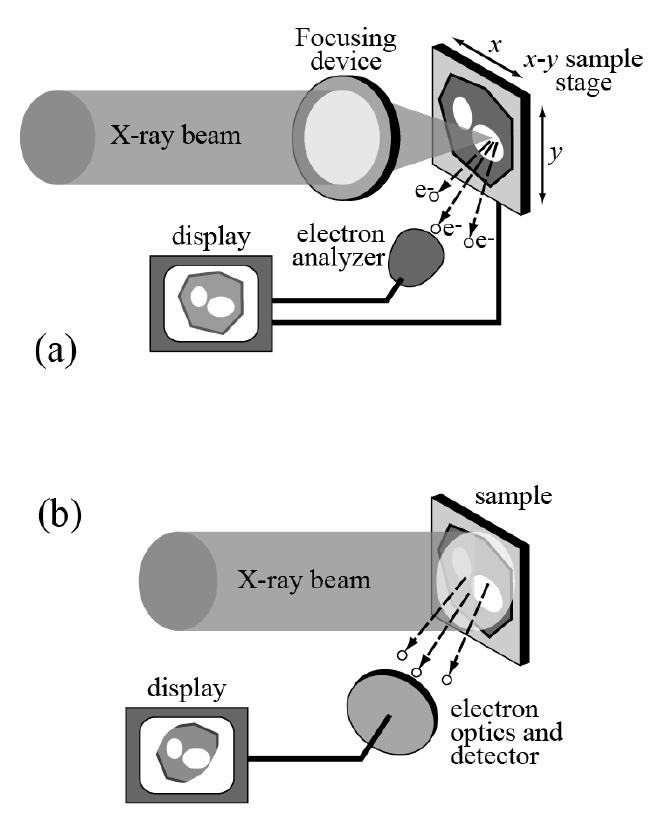
Figure 7. The two possible approaches to photoemission spectromicroscopy. In (a), lateral resolution is achieved by focusing the x-ray beam into a small spot and obtaining photoelectron spectra from the same sample area. An x - y stage can be used to scan the illuminated spot on the sample and obtain images. By selecting the photoelectron energy, such images can deliver specific microchemical information. In (b) the lateral resolution is achieved instead by using an electron optics